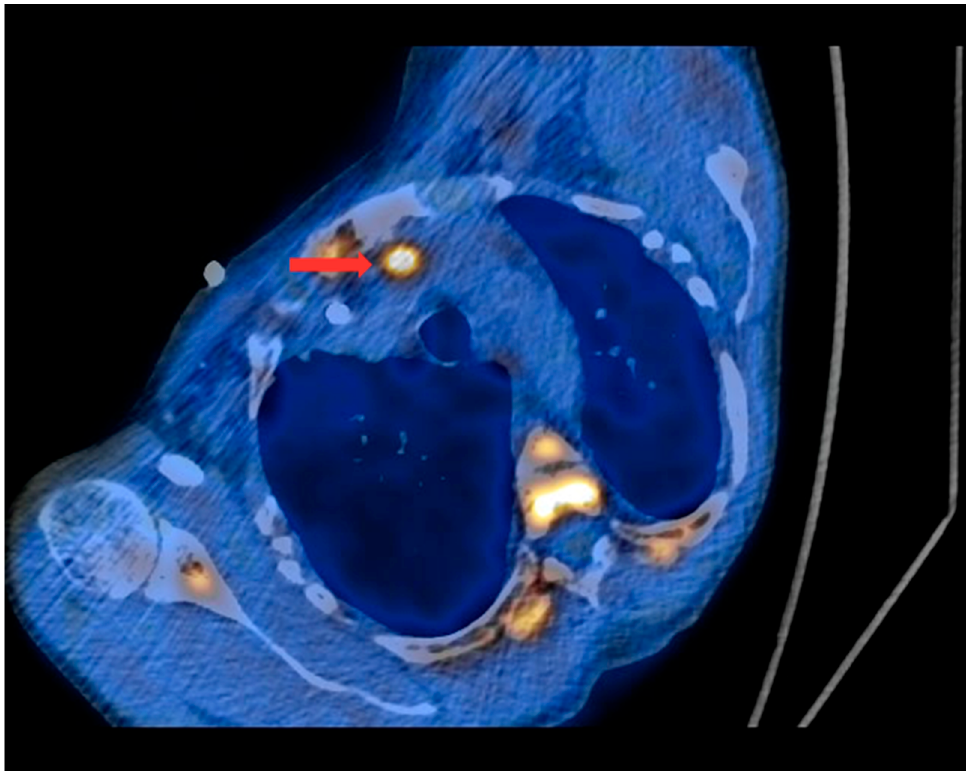
Figure 3. PET/CT with [ 11 C]MET—frontal projection. Two visible foci of increased radiotracer accumulation (red arrows) corresponding to the parathyroid glands (multiple lesions) below both thyroid lobes.